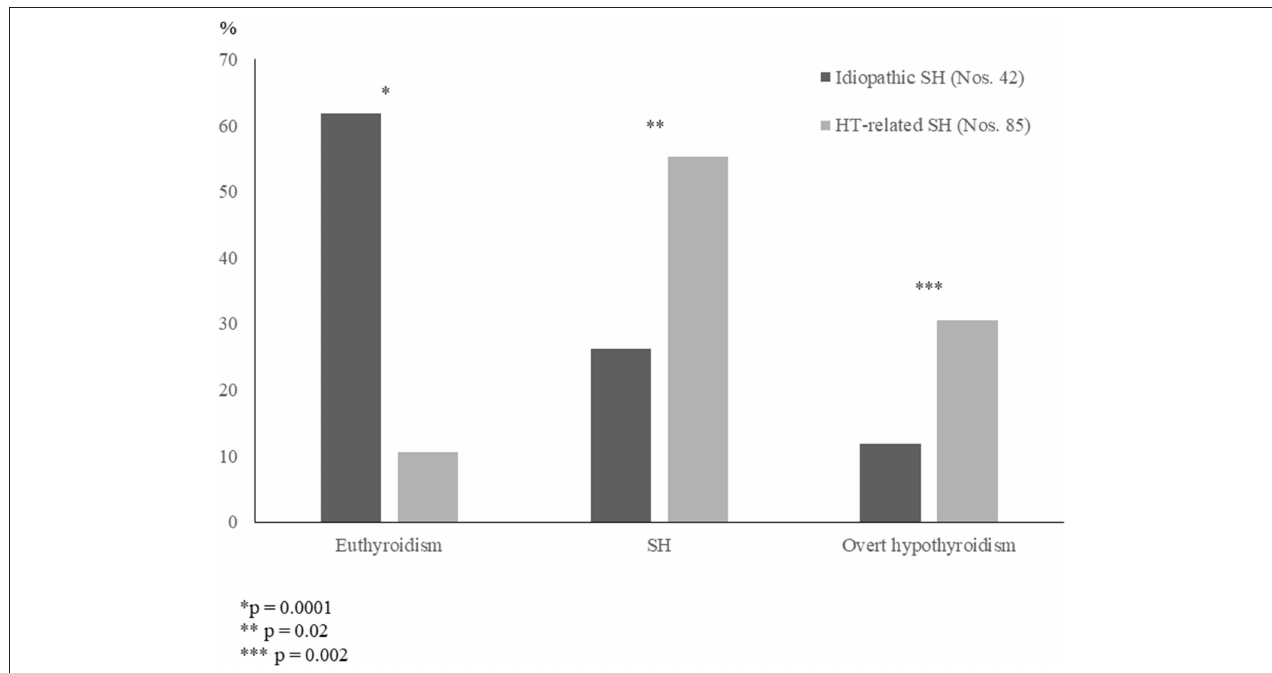
FIGURE 1 | Prevalence (%) of the main biochemical patterns of thyroid function found, at the conclusion of a 5-year follow-up, in two untreated groups of children who had initially presented with either idiopathic subclinical hypothyroidism (SH) or Hashimoto’s thyroiditis (HT)-related SH (according to the results of [14] study).